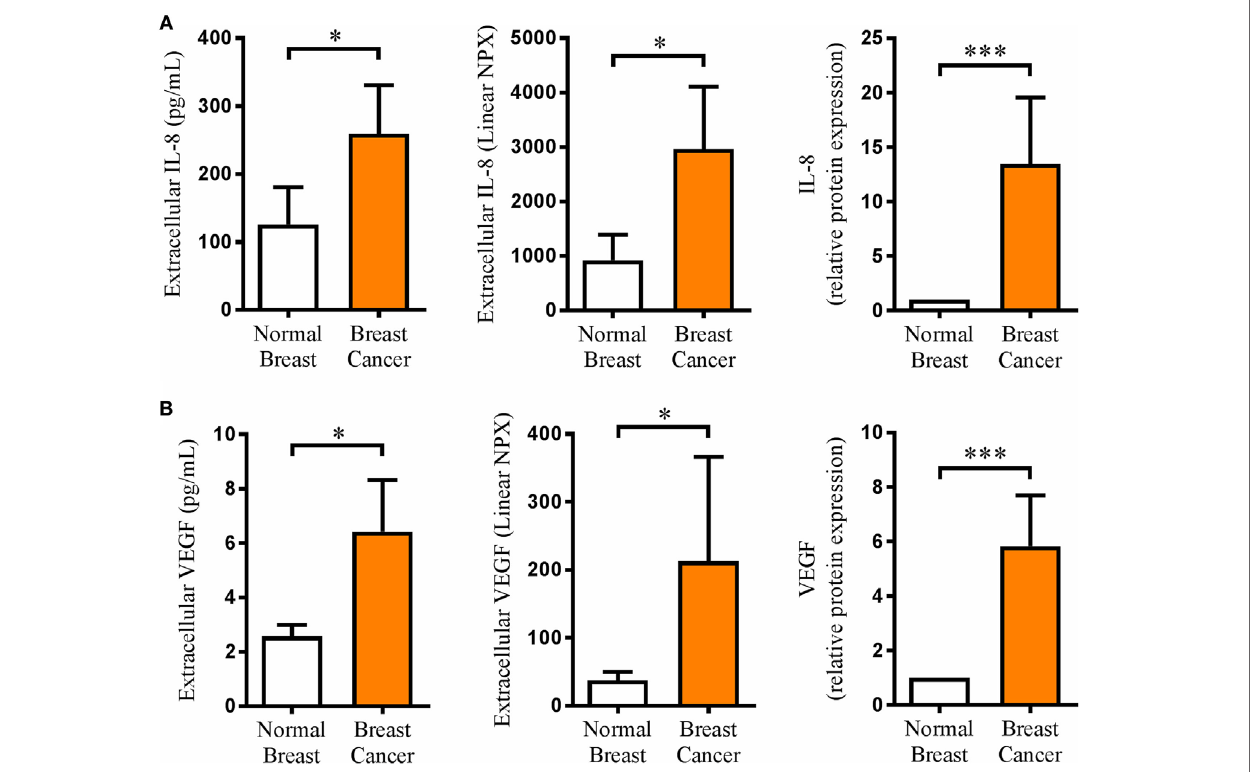
FigUre 1 | Extracellular in vivo levels of interleukin-8 (IL-8) and vascular endothelial growth factor (VEGF) were significantly increased in human breast cancer. A total of 17 breast cancer patients underwent microdialysis before surgery. One catheter was inserted into the breast cancer, and another catheter was inserted into adjacent normal breast tissue as control. Proteins were analyzed by Luminex in cohort 1 (expressed as pg/ml), n = 6 and by proximity extension assay (PEA) technology in cohort 2 (expressed as linear NPX), n = 11 as described in Section “Materials and Methods.” The bars to the right represent data from both cohorts normalized to the control in each cohort (relative protein expression), n = 17. (a) IL-8 in vivo measurements in microdialysis samples from breast cancer patients. (B) VEGF in vivo measurements in microdialysis samples from breast cancer patients. Results are presented as mean ± SEM and were analyzed pairwise by Wilcoxon signed-rank test, * p < 0.05, *** p < 0.001. IL-8 and VEGF exhibited a significant positive correlation by Spearman’s correlation test, r = 0.51 and p <